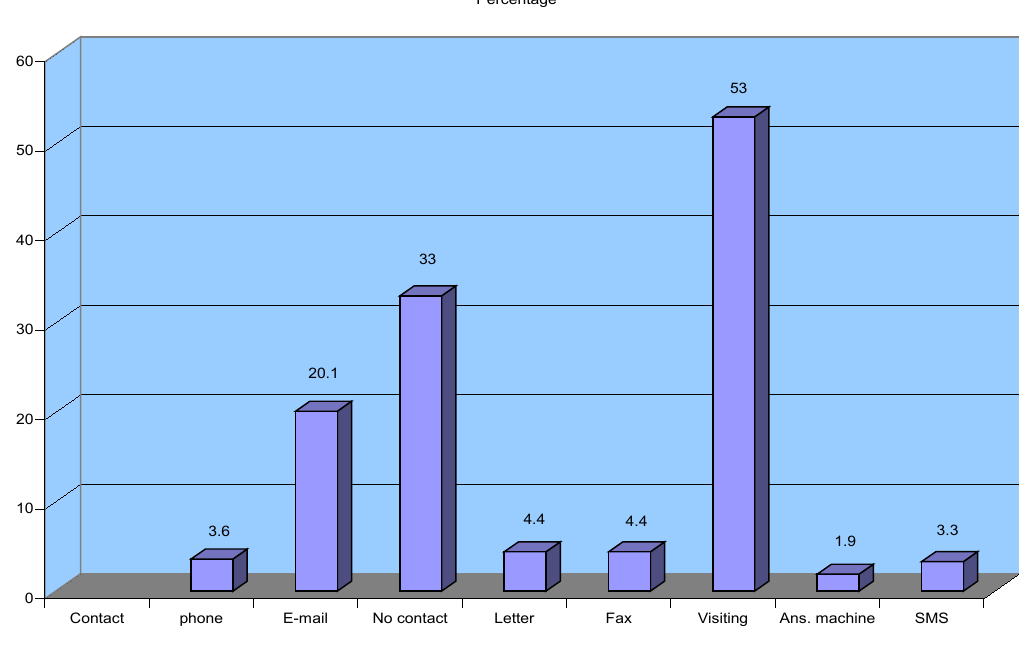
Figure 4. Contacting library/subject